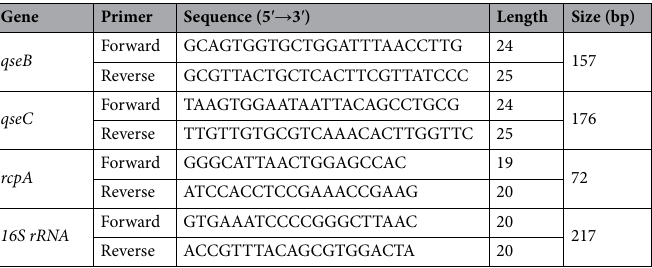
Table 1. Primer sequences used in this